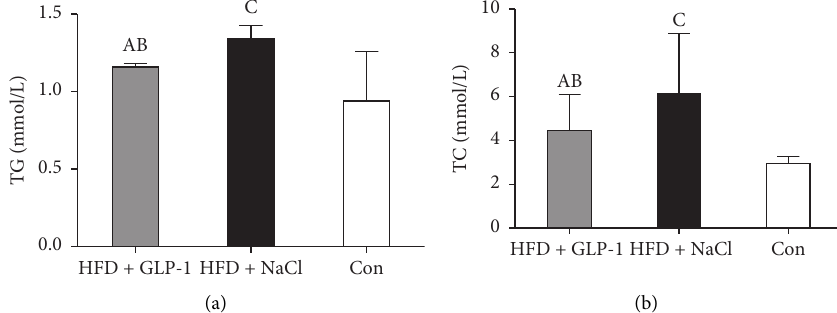
Figure 4: Lipid metabolism of three groups. Group A: HFD+GLP-1; Group B: HFD+NaCl; Group C: Con. (a) A: P � 0.022 vs. Group B; B: P � 0.265 vs. Group C; C: P � 0.047 vs. Group C. (b) A: P � 0.286 vs. Group B; B: P � 0.077 vs. Group C; C: P � 0.036 vs. Group C. TG: triglyceride; TC: total cholesterol.